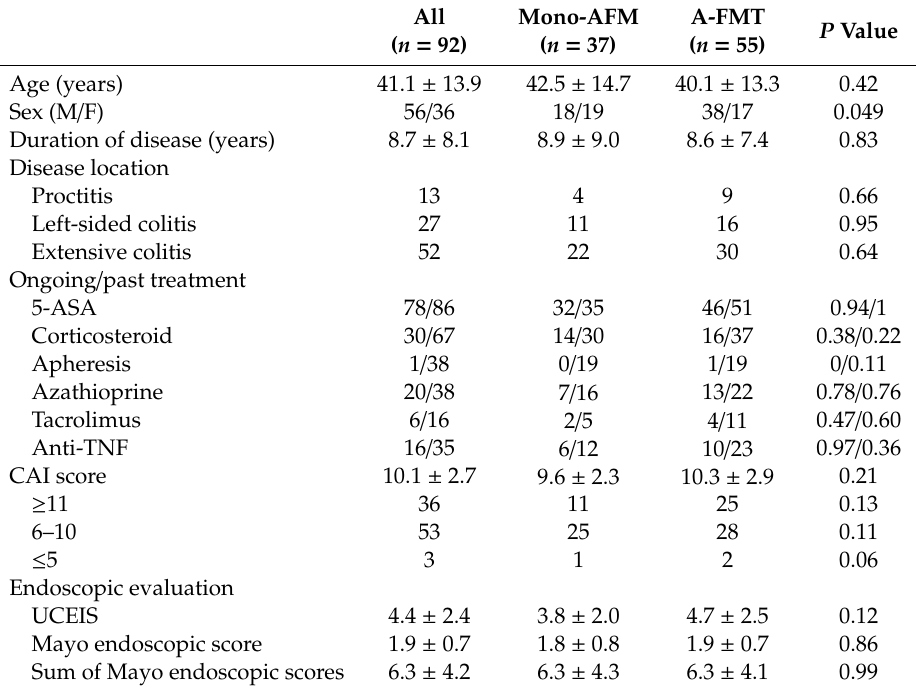
Table 1. Comparison of the baseline characteristics of patients who received mono-AFM and A-FMT.